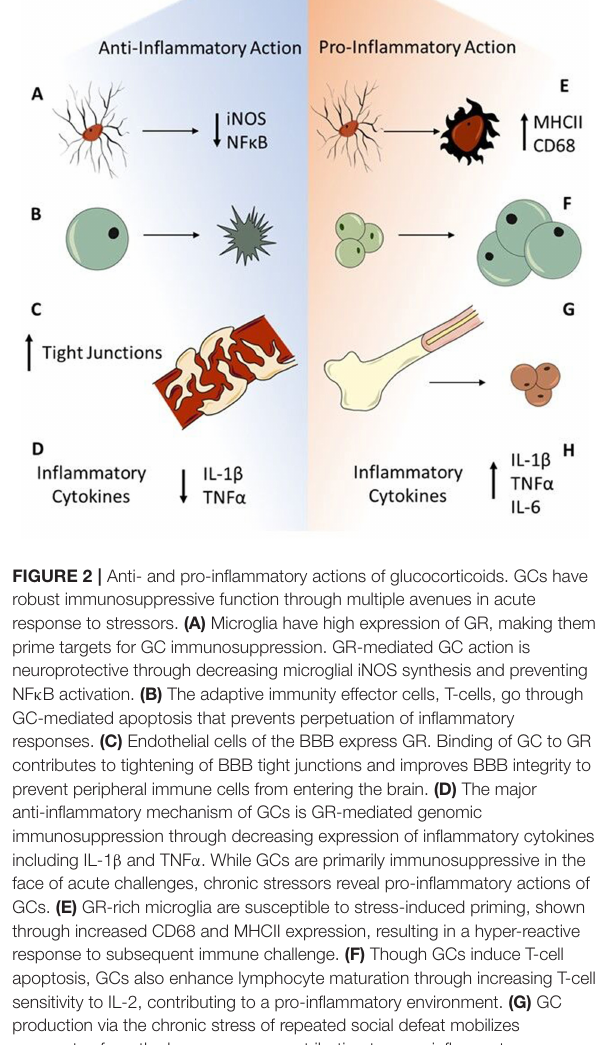
NF κ B. In mouse dendritic cell lines, induced iNOS